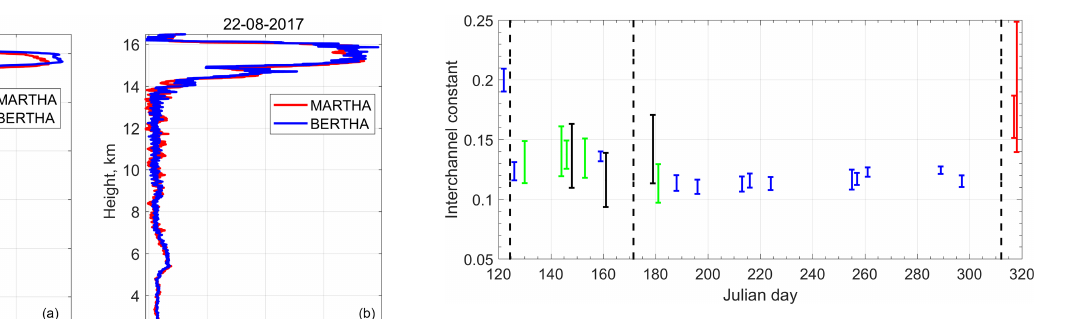
Figure 10. Time series of the interchannel calibration constant X δ measured from the end of April to mid-November 2017. The verti- cal bars show the uncertainty in the retrieval. The calibration proce- dure was based on lidar measurements in liquid-water clouds (blue) and cirrus clouds (green) and during optically thick cumulus events (black) and Saharan dust periods (red). The dashed lines indicate the days when changes in the attenuation configuration of the channels were made.